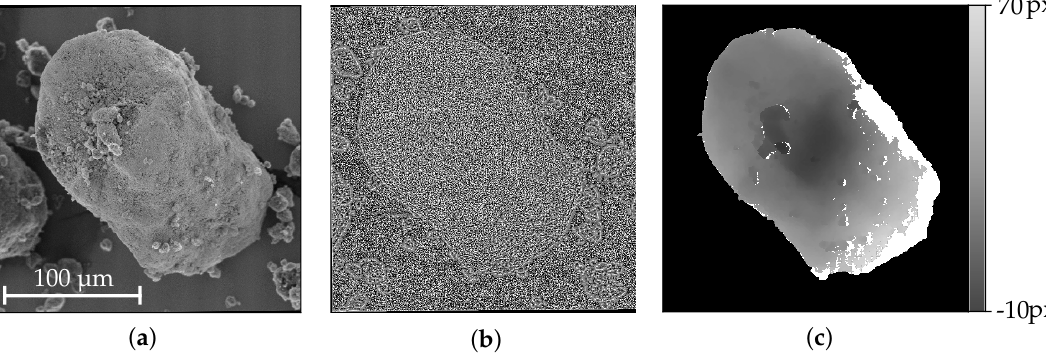
Figure 8. ( a ) Rectified image of a DEP agglomerate (DEP I); ( b ) Rank transformed image with a 9 × 9 window; ( c ) Disparity map illustrating the horizontal parallax between the images of a stereo-pair for a tilt angle of ∆ ϕ Y = 10 ◦ where black represents the background and white the area of the segmented particle. For the white parts, unreliable matches were